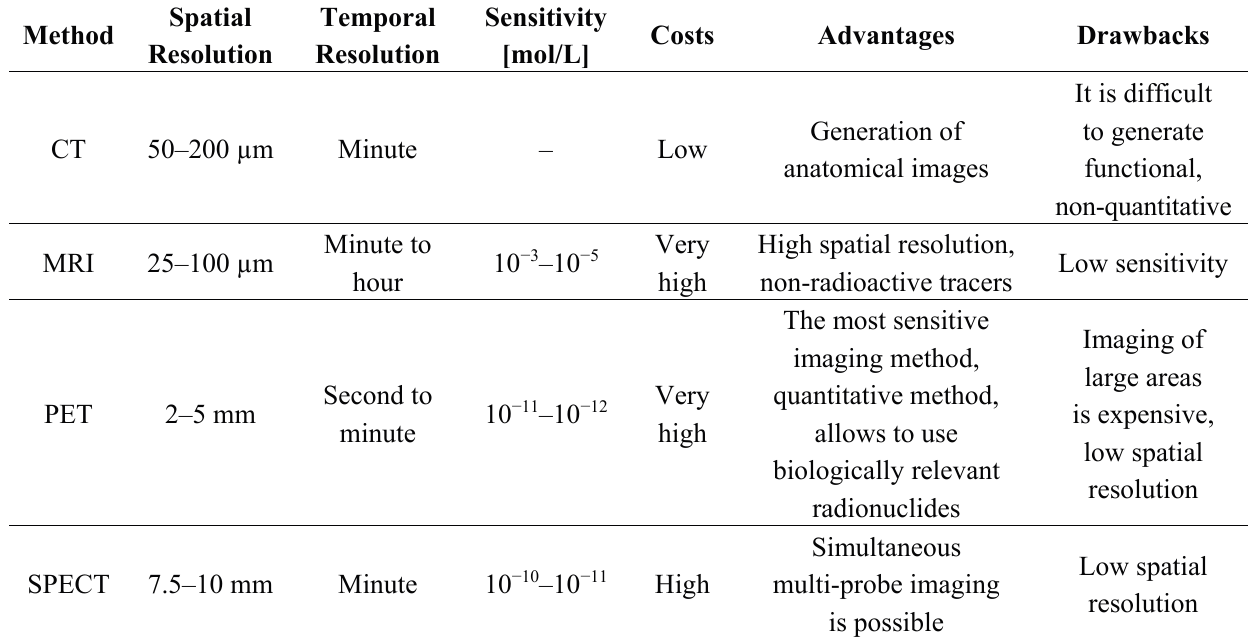
Table 2. Methods used for molecular imaging in oncology